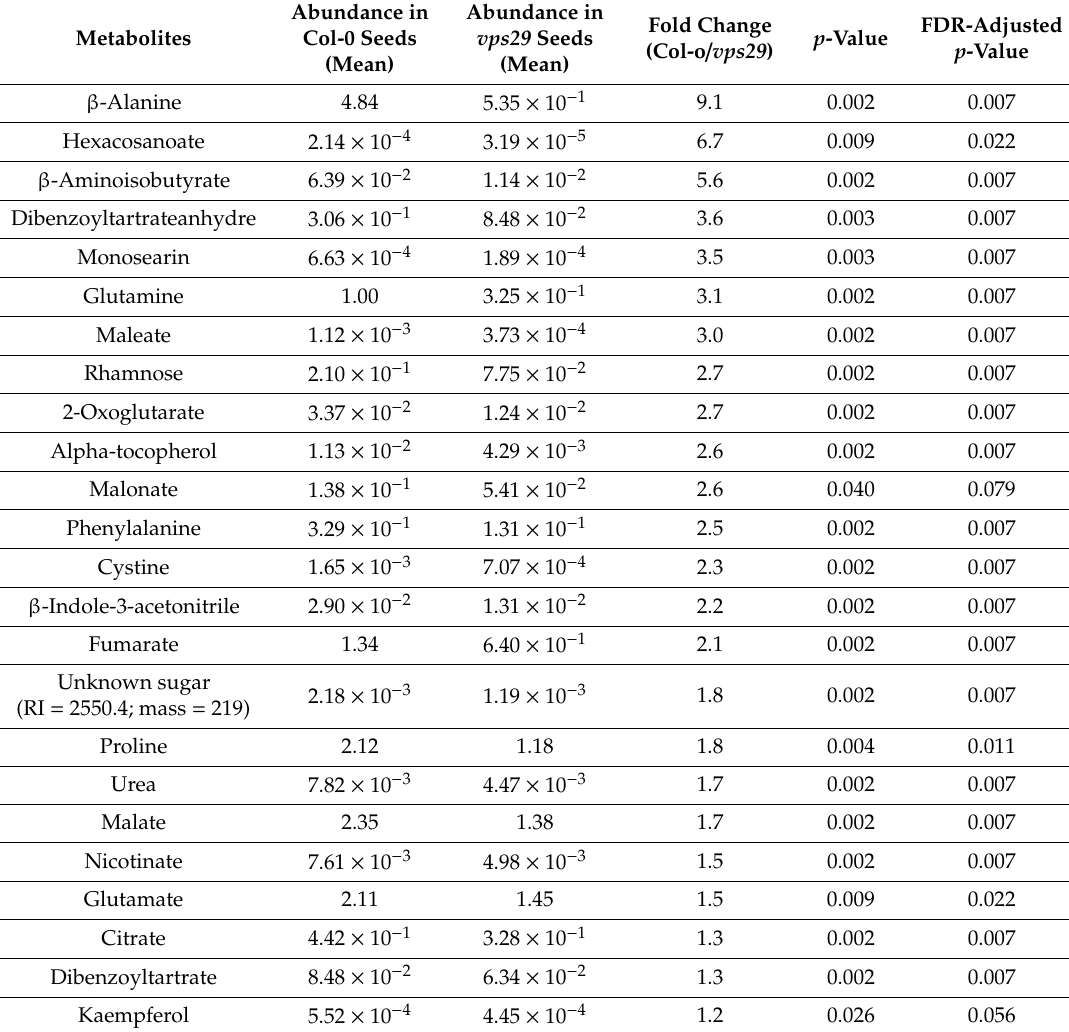
Table 1. Metabolites significantly up-accumulated in Col-0 dry seeds by comparison with vps29 dry seeds. A Kruskal–Wallis test and a Benjamini and Hochberg false discovery rate (FDR) adjustment were used with a significance level set at 5%. Significant p -values are indicated in bold. RI, retention index obtained from GC / MS analysis. Metabolites that were detected, but with no significant change in abundance between genotypes, are presented in the Supplementary Materials (Table